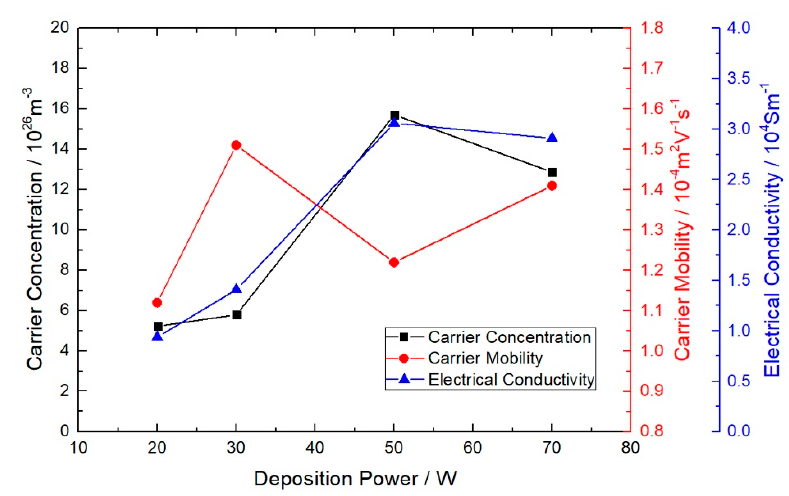
Figure 4. Semiconductor properties of the Bi 2 Te 3 films deposited under different powers by Hall tests.